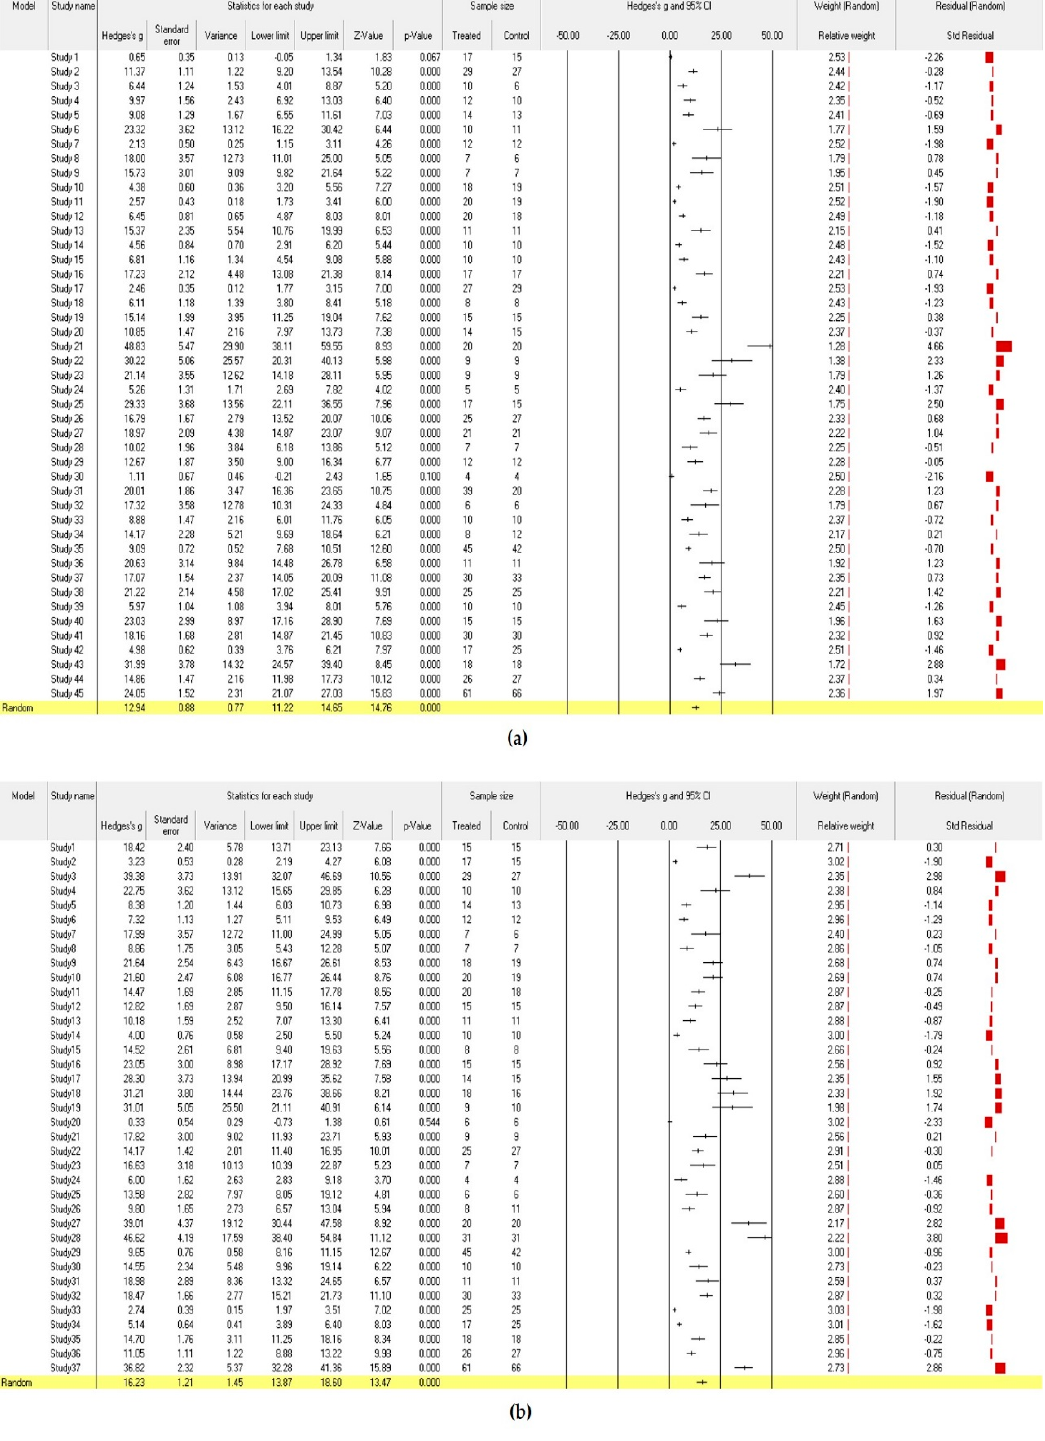
Figure 2. ( a ) E ff ect sizes of programs on cognition; ( b ) E ff ect sizes of programs on Figure 2. (a) Effect sizes of programs on cognition; (b) Effect sizes of programs on depression.